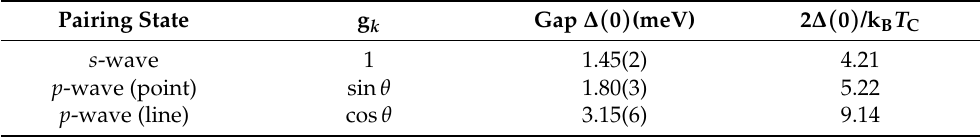
Table 1. A summary of the different gap symmetries were used to fit the magnetic penetration depth in Figure 2 for Na 2 Cr 3 As 3 with T C ∼ 8.0 K. The first column corresponds to the models in the figure, g k gives the angular dependence of the gap and 2 ∆ ( 0 ) /k B T C is the gap magnitude in the calculation that best fitted the